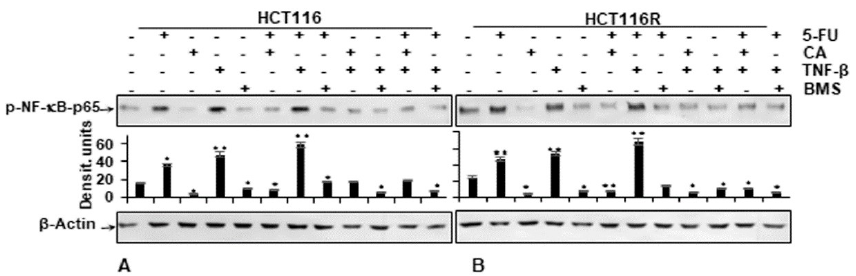
Figure 6. E ff ect of Calebin A or BMS-345541 and / or 5-FU on TNF- β -promoted p65-NF κ B activation in CRC cells Serum-starved monolayer cultures of HCT116 ( A ) and HCT116R ( B ) were treated as described in the Materials and Methods section and whole-cell lysates immunoblotted for phospho-